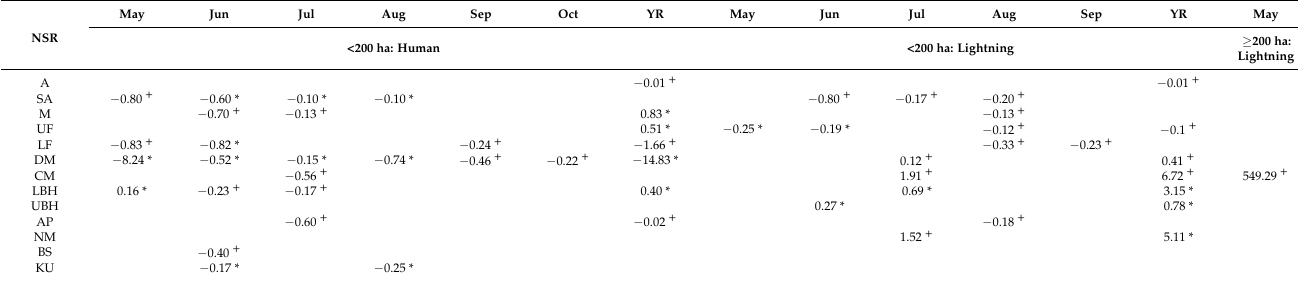
Table 4. Significant trends of the monthly and annual BA during 1959–2021 in the natural subregions of Alberta. Slopes (hectares/year) at the significance levels of 99% (*) and 95% ( + ) are presented for large and small fires caused by human and lightning.